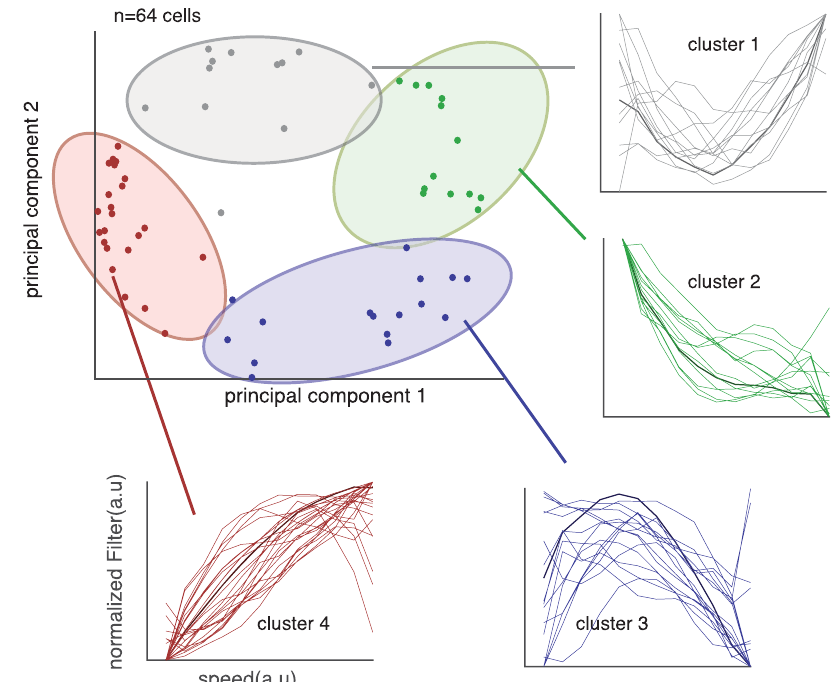
Fig. 4 Diversity in responses of neurons to speed. We examined whether speed tuning re fl ects a single response pro fi le, as would be expected if, for example, speed effects were simply an artifact of arousal. We performed a PCA procedure on all tuning curves and plot the results as a function of each PC. We then cluster the resulting patterns and show all tuning curves within each cluster. The diversity of responses, and especially the existence of clearly ditonic clusters (clusters 1 and 3), argues against an arousal